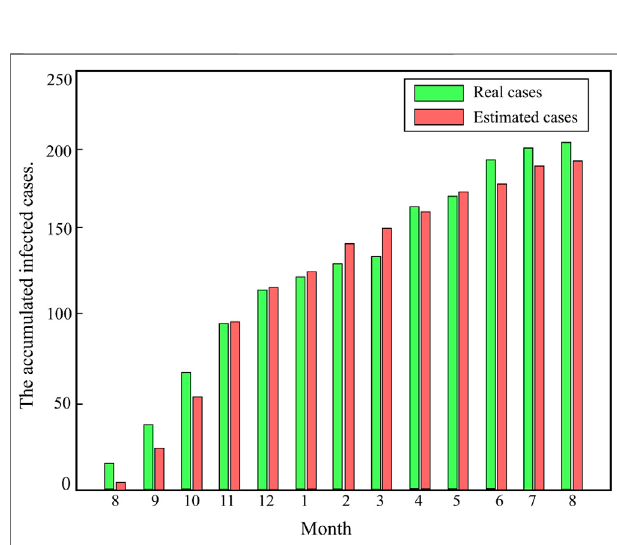
FIGURE 6 | Real accumulated infected cases and estimated accumulatedinfected casesthroughthespatiotemporalforward transmission algorithm in mainland